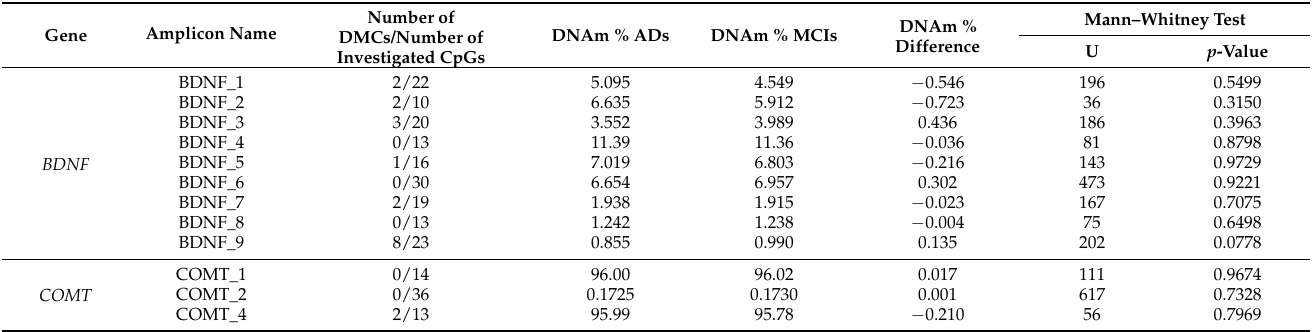
Table 3. DNA methylation status of BDNF and COMT gene amplicons. DNA methylation values are presented as average DNA methylation percentage per studied